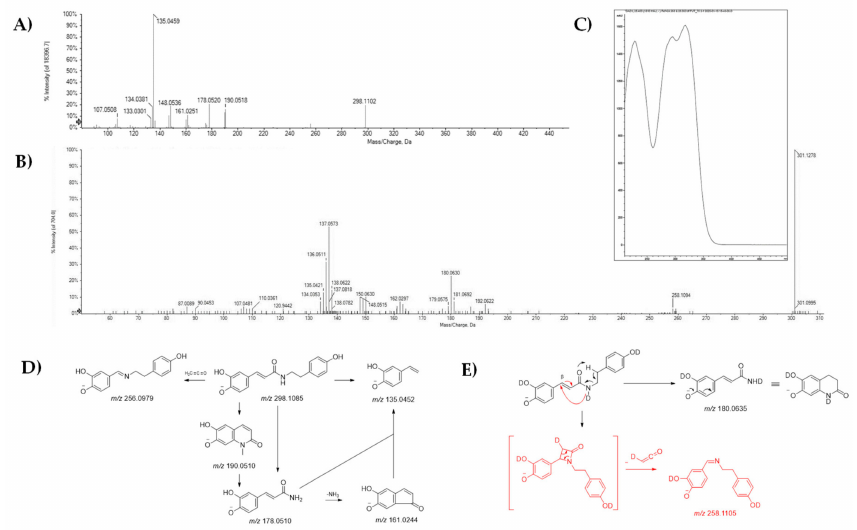
Figure 2. TOF-MS / MS spectra of compound 5 ( A ) and of its 3d-derived ( B ). UV-DAD spectrum of the compound ( C ). Proposed fragmentation pathway of the [M − H] − ion for compound 5 ( D ) and the 3 d -derived ( E ); theoretical m / z value is reported below each